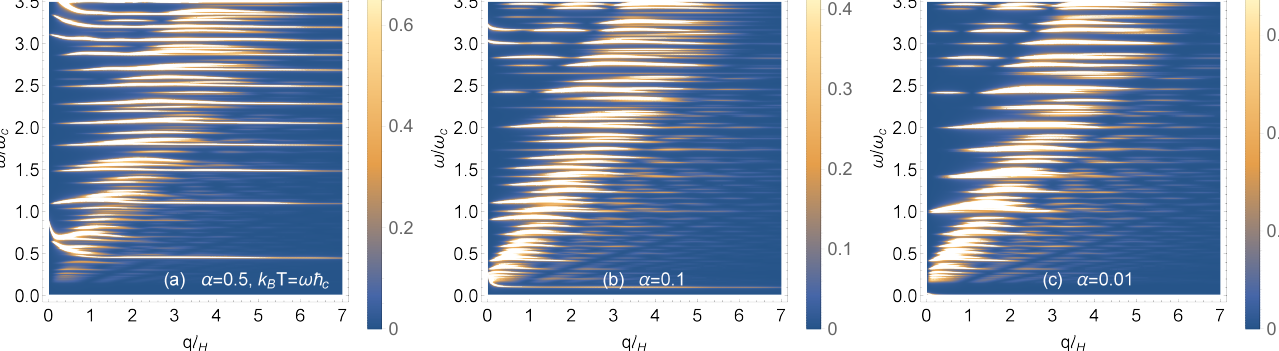
Figure 9. Density plots of the magnetoplasmon dispersion relation for various hopping parameters ( a ) α = 0.5, ( b ) α = 0.1, and ( c ) α = 0.01. The temperature is chosen as k B T = ¯ h ω c